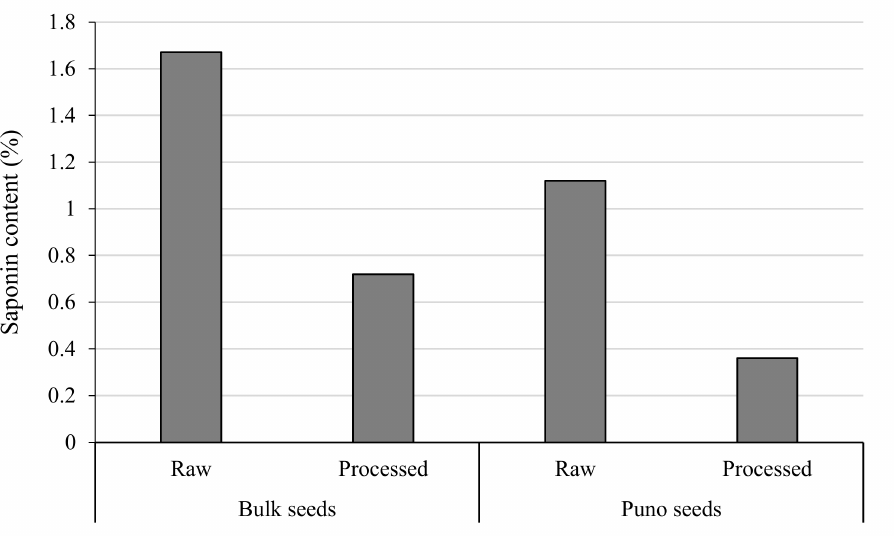
Figure 2. Saponin content (%) of raw and processed bulk and Puno seeds. Bulk seeds were pearled manually and Puno seeds mechanically using quinoa